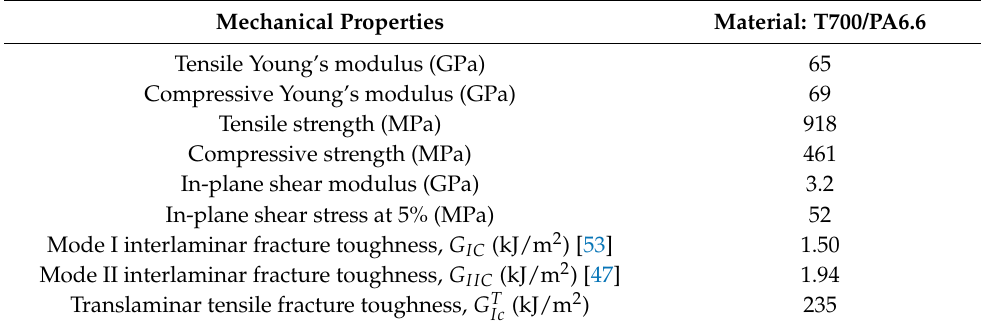
Table 2. Quasi-static mechanical properties of T700/PA6.6 with a fiber-volume-fraction of 52% [47,53,54]. Mechanical